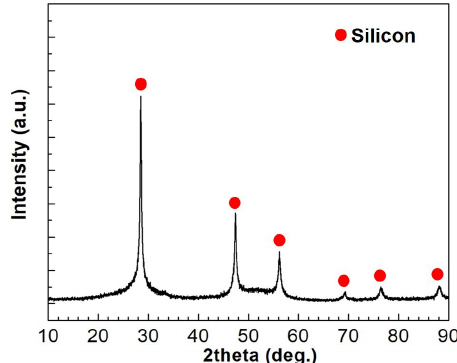
Figure 2. XRD pattern of the Si sludge which was used in the present study. Appl. Sci. 2018 , 8 , 1841